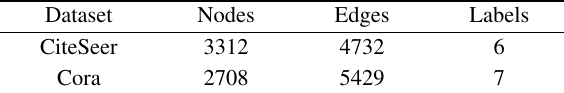
Table 2 Datasets used in our